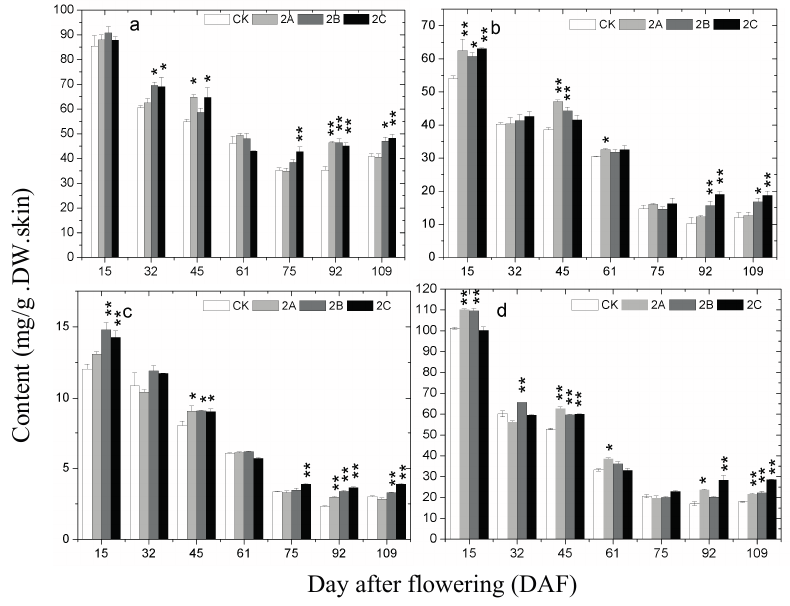
Figure 5. The change of ( a ) total polyphenol; ( b ) total flavonoids; ( c ) total flavanols; and ( d ) condensed tannins content in grape skin with developmental stages in the control and the Zn-treated groups in 2014. The asterisk represents the content in the zinc treatment group is significantly different than the control group at 1% level (for two asterisks) and 5% level (for one asterisk), respectively.